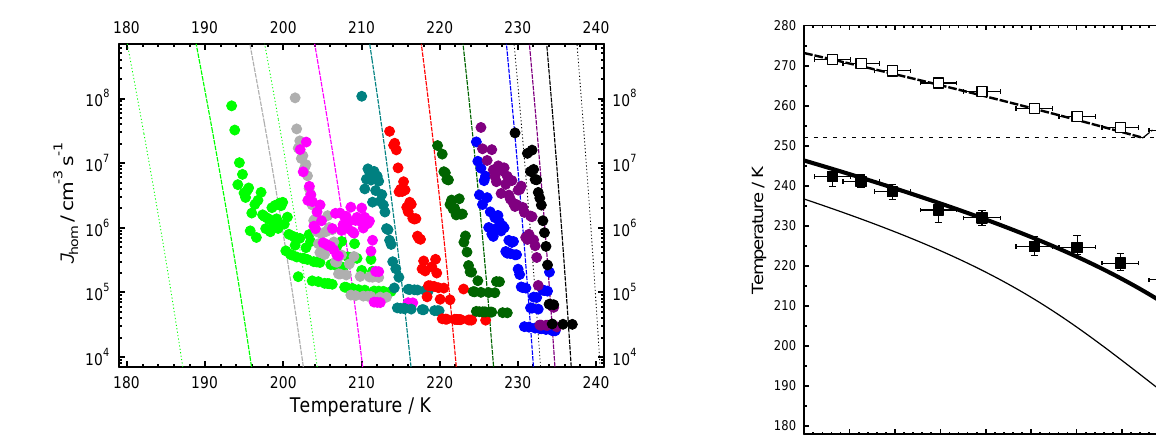
Fig. 3. Experimentally derived homogeneous ice nucleation rate coefficients, J hom (circles), and theoretically predicted J hom values (dashed lines) (Koop et al., 2000b) shown as a function of T and a w . Black, purple, blue, green, red, teal, magenta, gray, and lime colors correspond to aqueous NaCl droplets with initial a w of 0.984, 0.970, 0.953, 0.924, 0.900, 0.874, 0.851, 0.826, 0.806. The uncertainty for predicted J hom due to an uncertainty in a w of ± 0.025 is indicated as dotted lines for a w of 0.984 and 0.806.